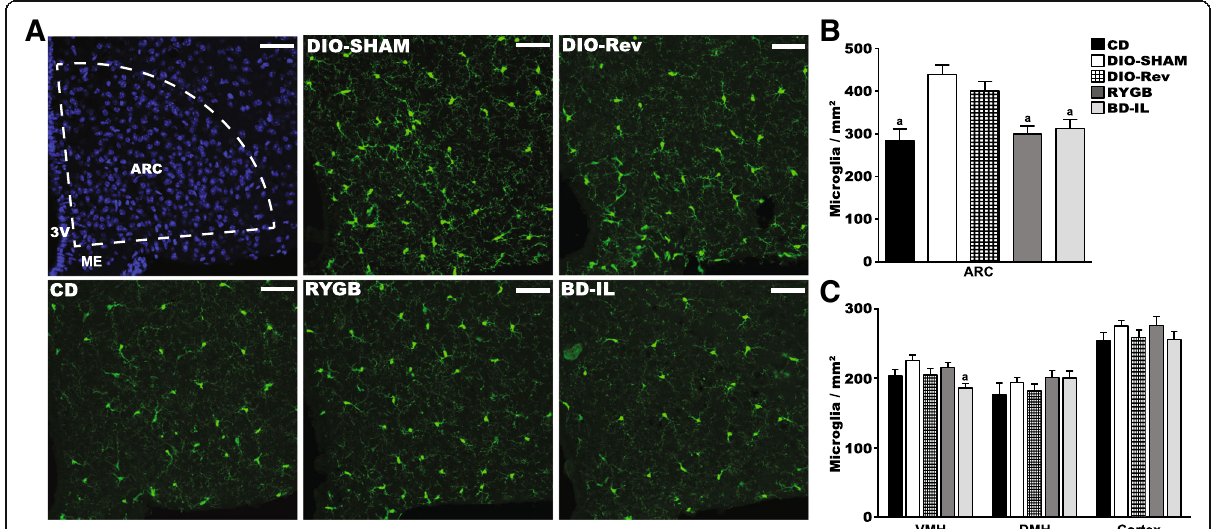
Fig. 3 RYGB and BD-IL procedures normalize HFD-induced hypothalamic microgliosis. a Representative images of GFP fluorescence from bariatric surgical mice and controls taken at Bregma − 1.6 to − 1.9. Top left image shows DAPI staining of mediolbasal hypothalamus at this level, with the dashed lines defining the anatomical borders of the arcuate nucleus (ARC). 3 V, third ventricle. ME, median eminence. Scale bar=50 μ m. b Quantification of microglia in the arcuate nucleus following sacrifice ( n =4 – 5 mice per group, 2 – 3 sections per mouse). c Quantification of microglia in other mediobasal hypothalamic nuclei as well as cortex. a=significant difference from DIO-SHAM. p <0.05 ( n =5 – 6 per group). Data are represented as mean±SEM